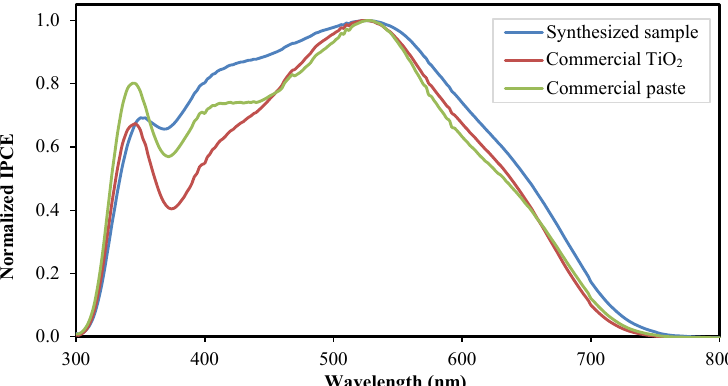
Figure 10. IPCE spectra of the fabricated DSSC integrated with the synthesized sample, the commercial TiO 2 , and the commercial paste as the photoelectrode film.